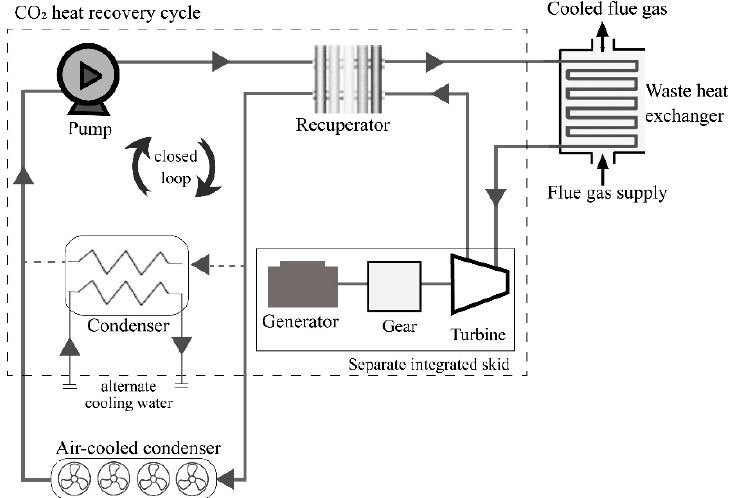
Figure 5. Schematic representation of the supercritical carbon dioxide cycle.